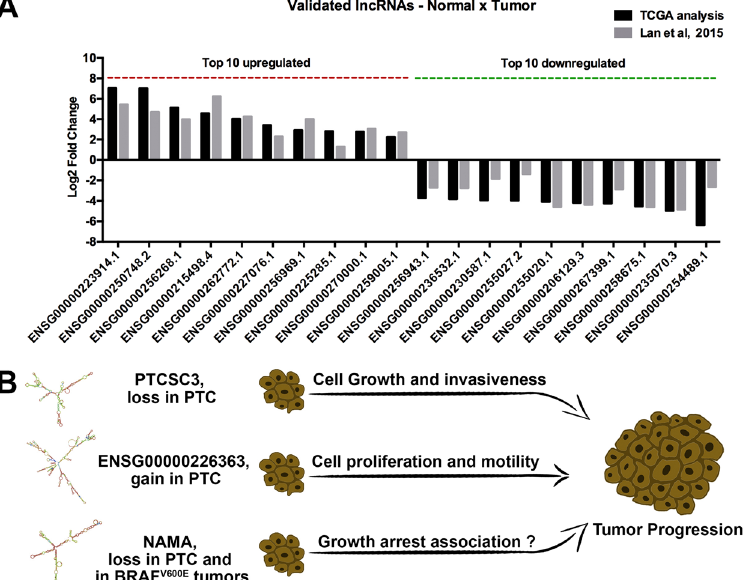
Figure 5. Experimentally validated lncRNAs are important to tumor malignancy. ( A ) Examples of DE lncRNAs between Normal and PTC, which were confirmed in a validation set 36 . ( B ) Differentially expressed lncRNAs in PTC that alter tumor